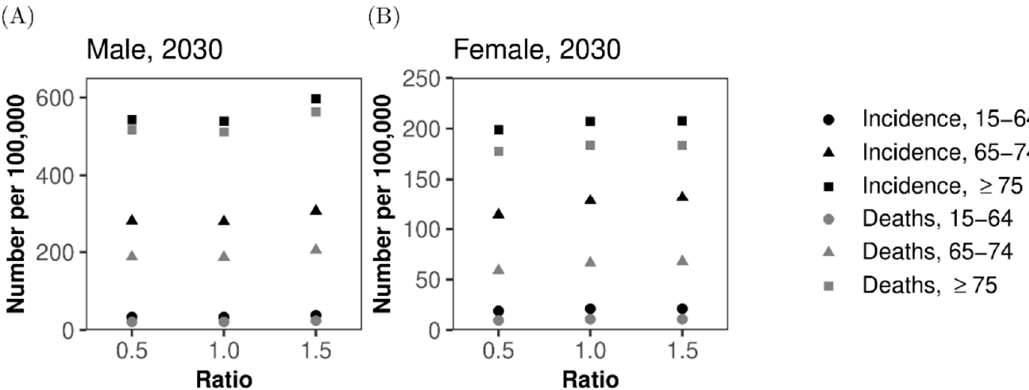
Figure 6. Sensitivity of lung cancer incidence and mortality to the relative hazard ratio among smokers. Predicted incidence and mortality of lung cancer are examined according to the different relative hazard ratios of lung cancer among smokers. ( A ) Incidence and mortality in men and ( B ) Incidence and mortality in women. Black marks show the incidence, while grey marks represent mortality. Circles, triangles, and squares represent those aged 15–64 years, 65–74 years, and 75 years or older, respectively.